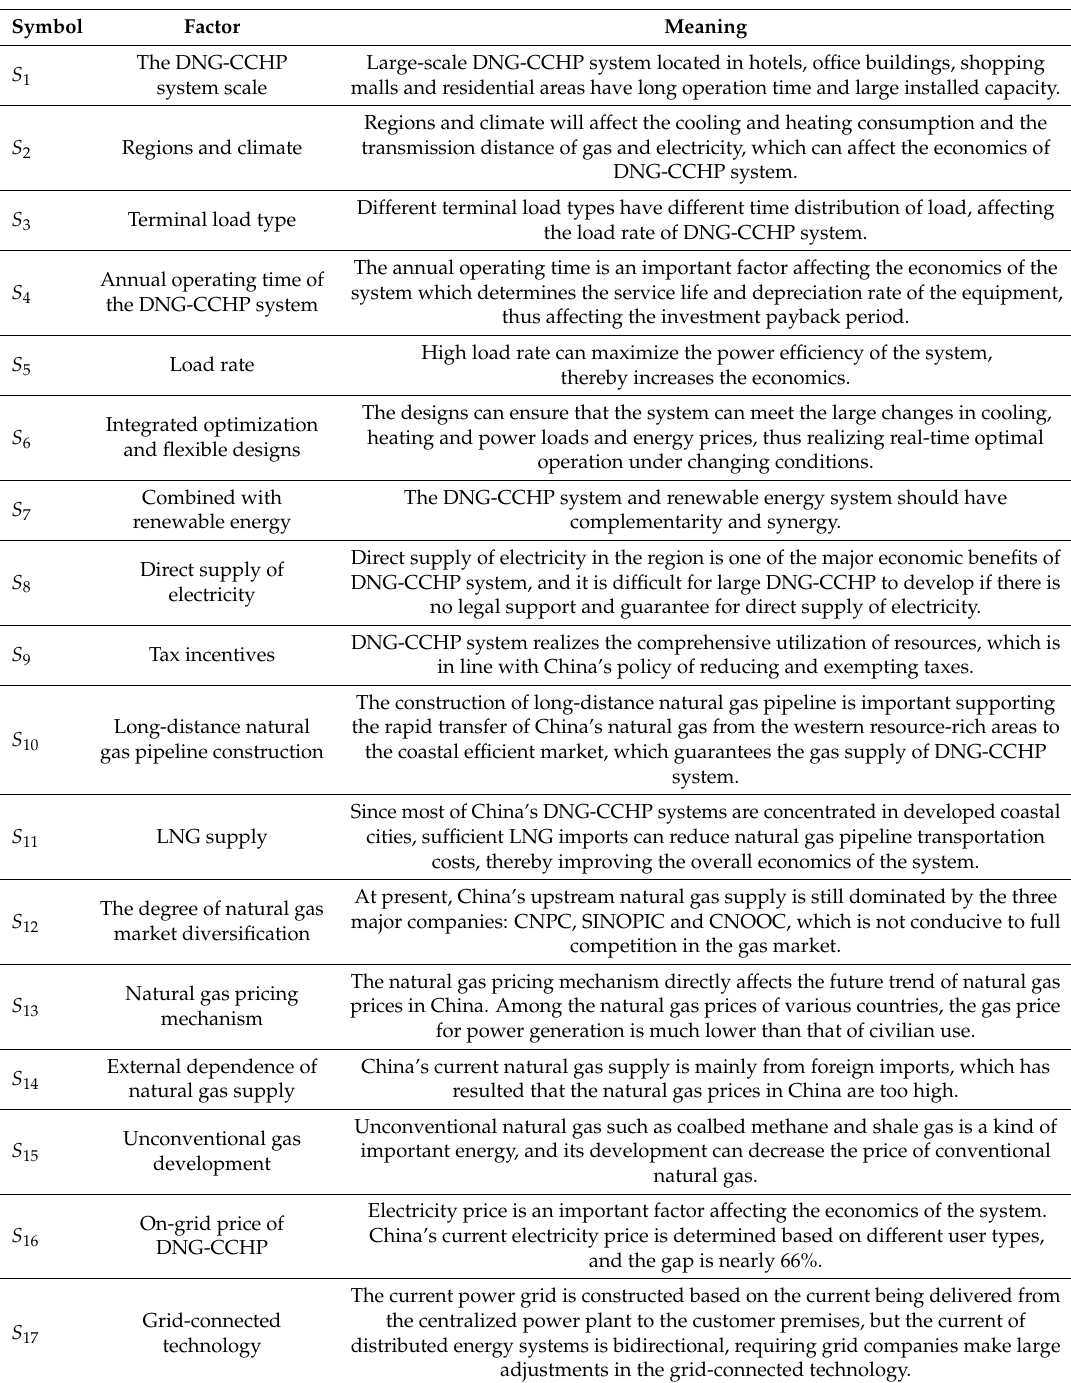
Table 1. Factors influencing the economics of DNG-CCHP